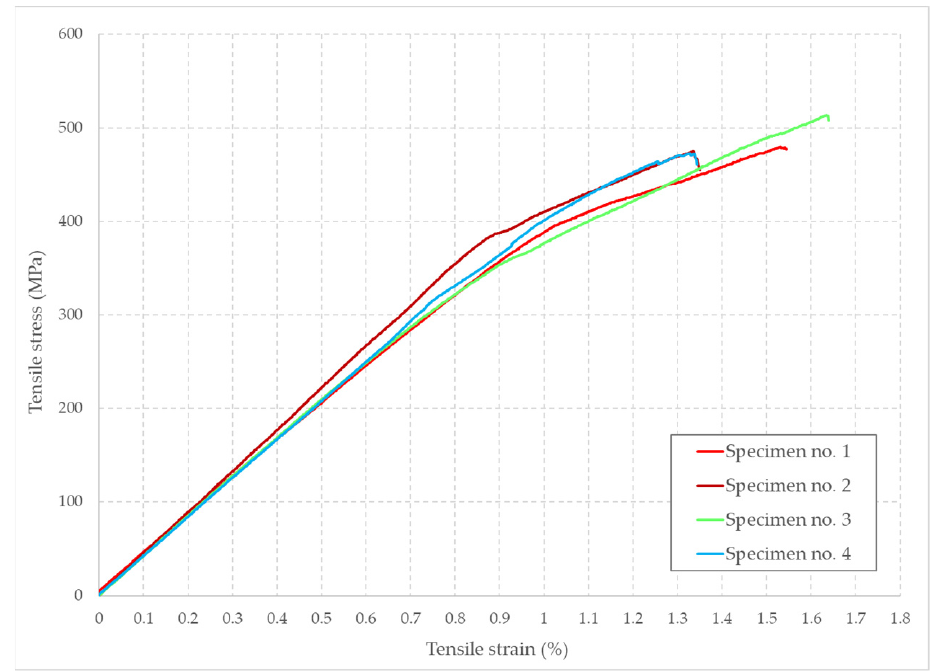
Figure 9. The stress–strain diagram for the multi-ply test specimens.